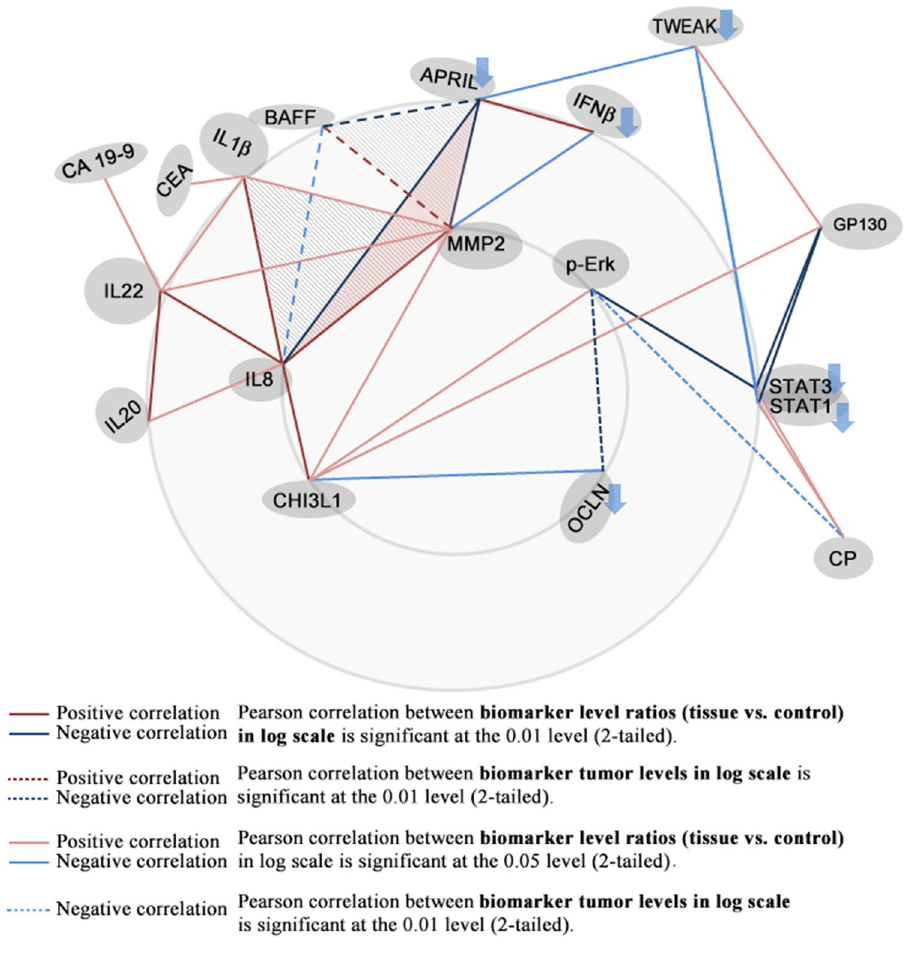
Figure 4. Correlated biomarkers pairs connected according to their two by two positive (in red) or negative (in blue) Pearson correlation significance levels. All Pearson correlation values are shown in the Fig. 3 correlation